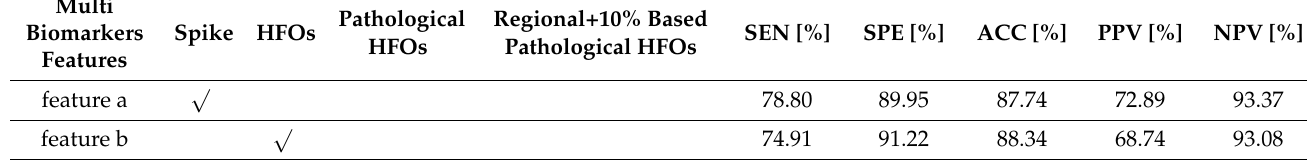
Table 6. The ablation study demonstrates that the features in our pipeline are efficient for detecting SOZ